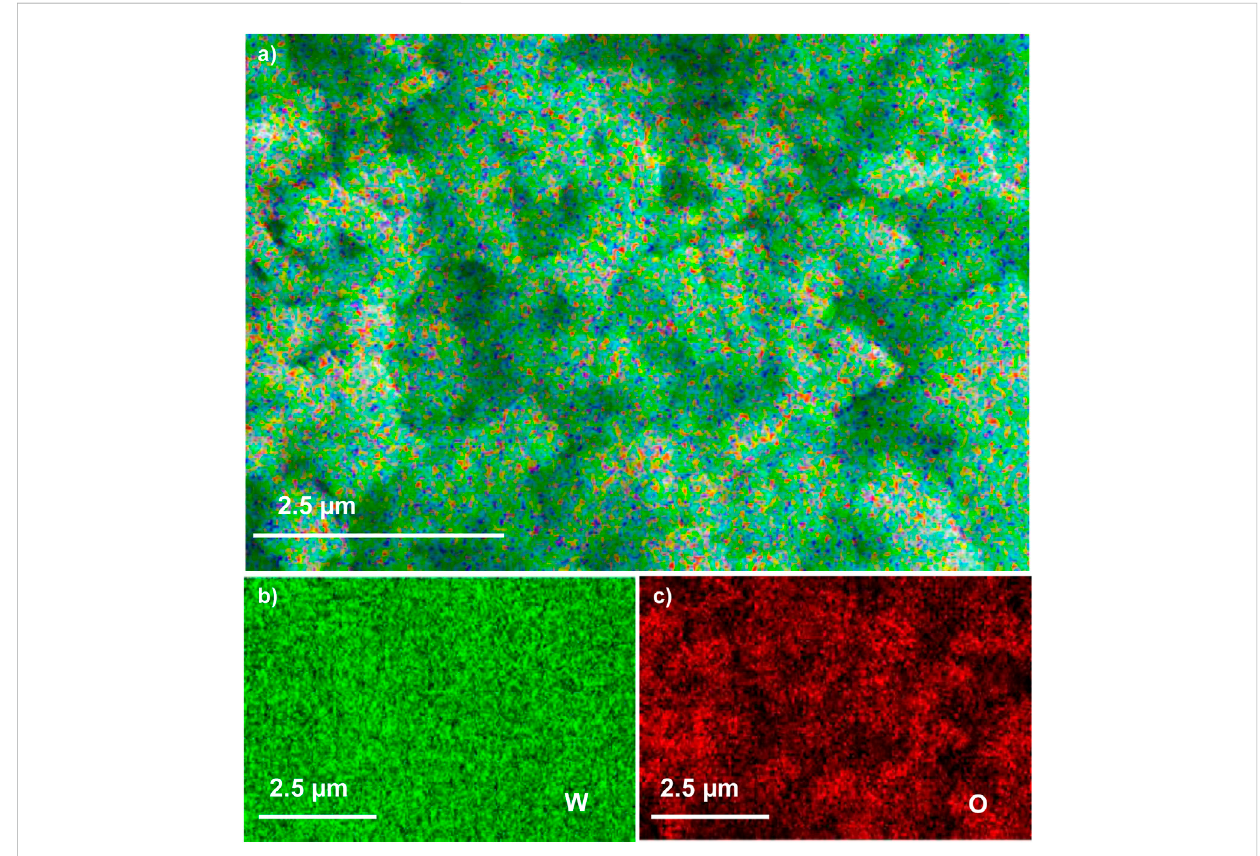
FIGURE 4 TheEDXmicrographof (A) WO 3 -H 2 SO 4 sample,anditscorrespondingelementsmappingof (B) W,and (C) O,basedonSEMimagesofWO 3 -H 2 SO 4 .